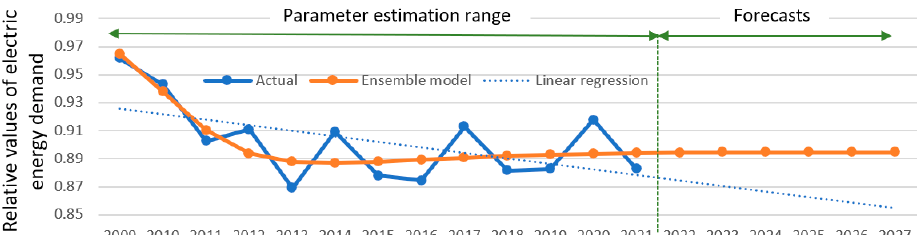
Figure 13. Comparison of forecast outcomes from the linear regression model and non-linear Ensemble Model at 4:00 am on the winter typical day.